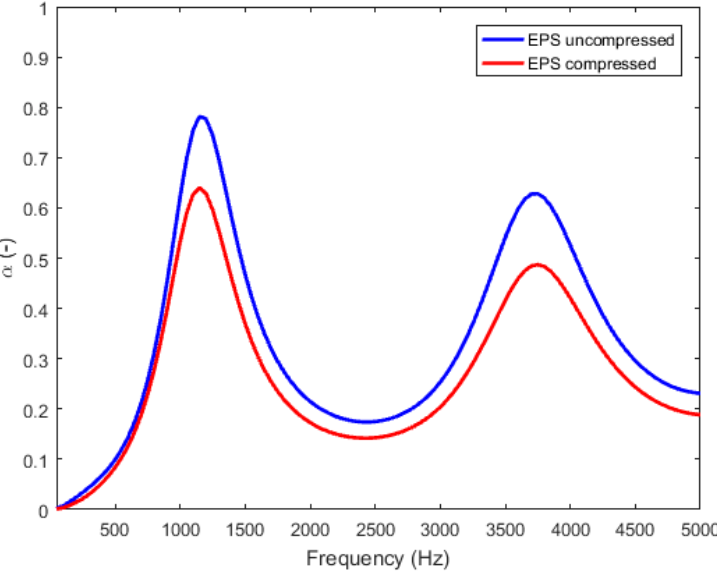
Figure 10. Normal sound absorption spectra of the uncompressed and compressed EPS foam modelled using ScalingCell.